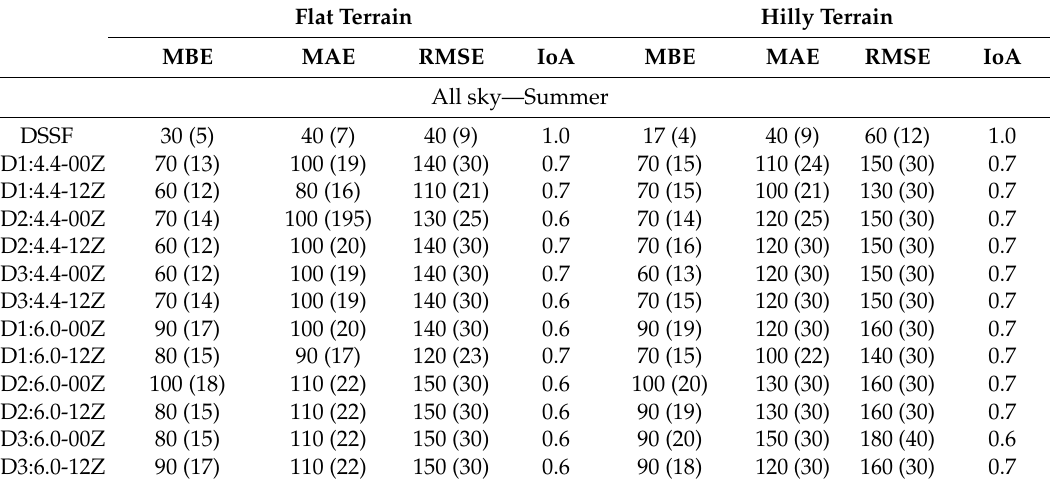
Figure 3. Same as Figure 2, but during the winter 2010–2011: flat-clear ( a ); flat-cloudy ( b ); hilly-clear ( c ) and hilly-cloudy ( d ). Statistical scores values (RMSE and MBE) presented in W·m − 2 . Table 1. Daily solar radiation error and accuracy statistics, depending on flat or hilly terrain and considering all sky conditions, during the summer 2011 and the winter 2010–2011. Mean bias error (MBE), mean absolute error (MAE) and root mean square error (RMSE) in W·m − 2 . Relative errors (%) rMBE, rMAE and rRMSE in brackets at the right.